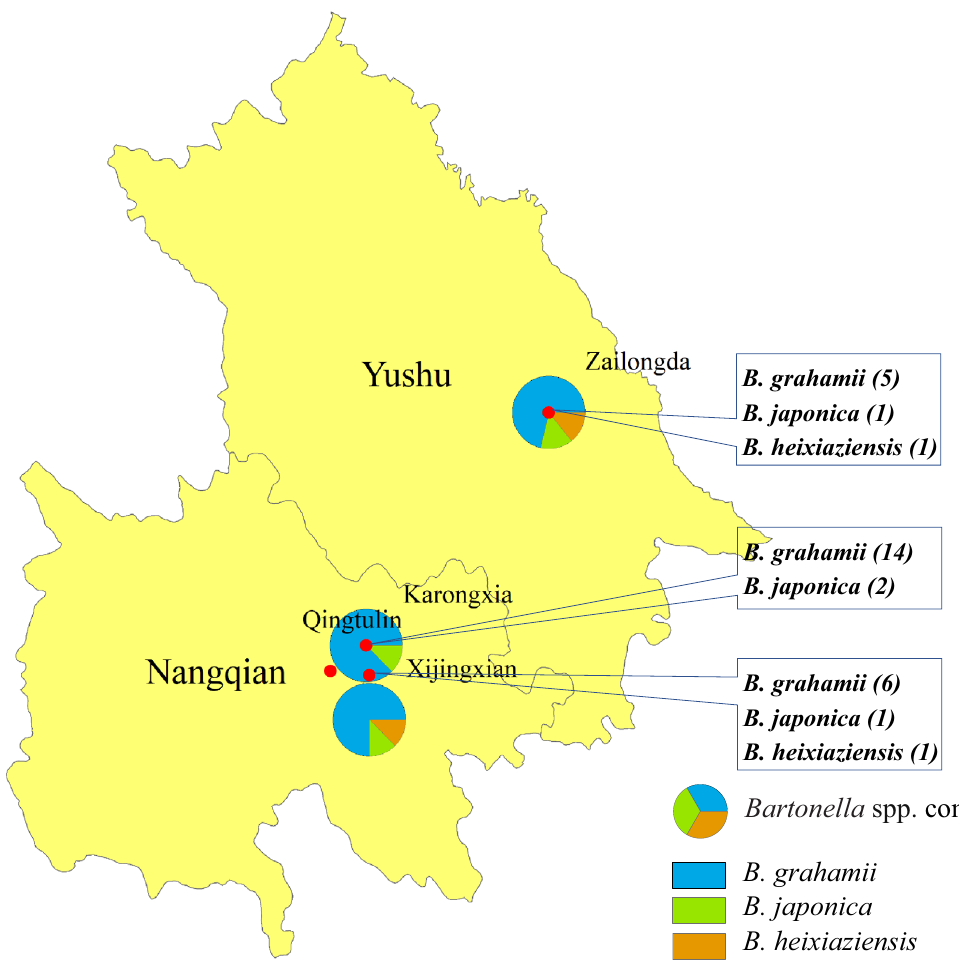
Figure 3. Bartonella species composition in different sampling sites in the central region of the Qinghai- Tibetan Plateau, China. The map was prepared in ArcGIS 10.2.2 using political boundaries from the National Geomatics Center of China (http:// www. ngcc. cn/ ngcc) for illustrative purposes only, these data are available free of